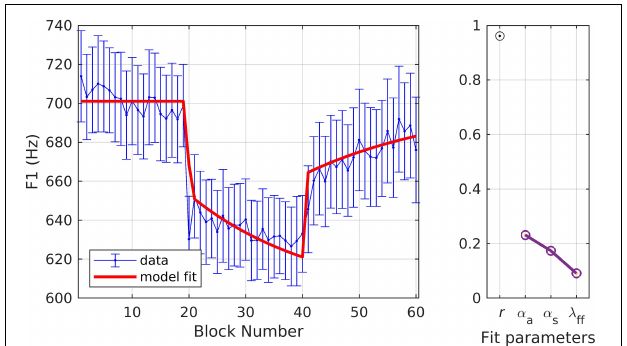
FIGURE 3 | Simulation 1: model fits of a dataset with upward perturbations to F1 (data from Haenchen, 2017; Scott et al., 2019). (Left) Mean and standard error of experimental data in blue; model fit in red. (Right) Fit quality and optimized parameter values ( r = correlation coefficient; α A = auditory feedback control gain, α s = somatosensory feedback control gain, and λ FF = learning